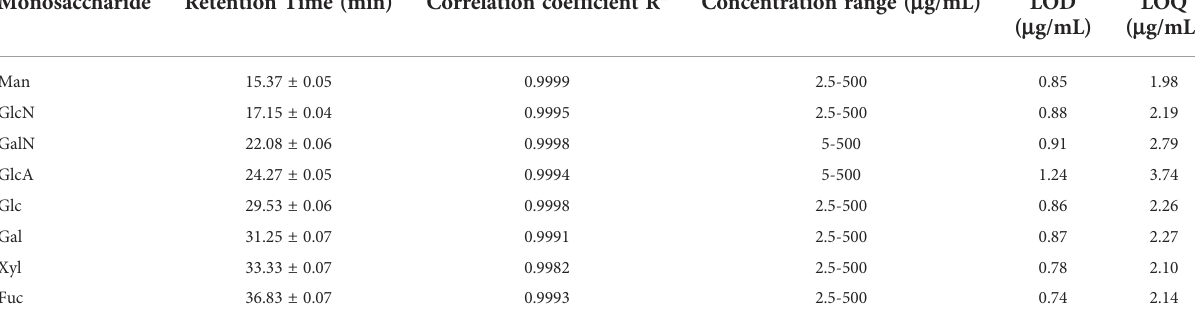
TABLE 1 Analytical performance of the